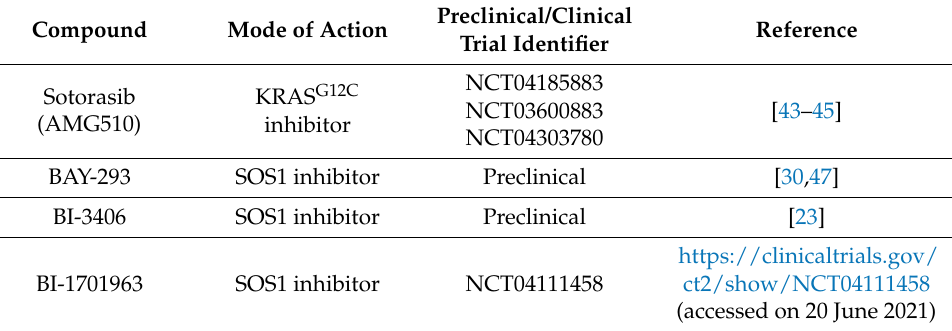
Table 1. Inhibitors of SOS GEF function in pathological contexts. List of compounds and experi- mental evidence documenting their ability to disrupt functional interactions of SOS and RAS targets in RAS:SOS complexes, or to directly inhibit the intrinsic GEF activity of SOS